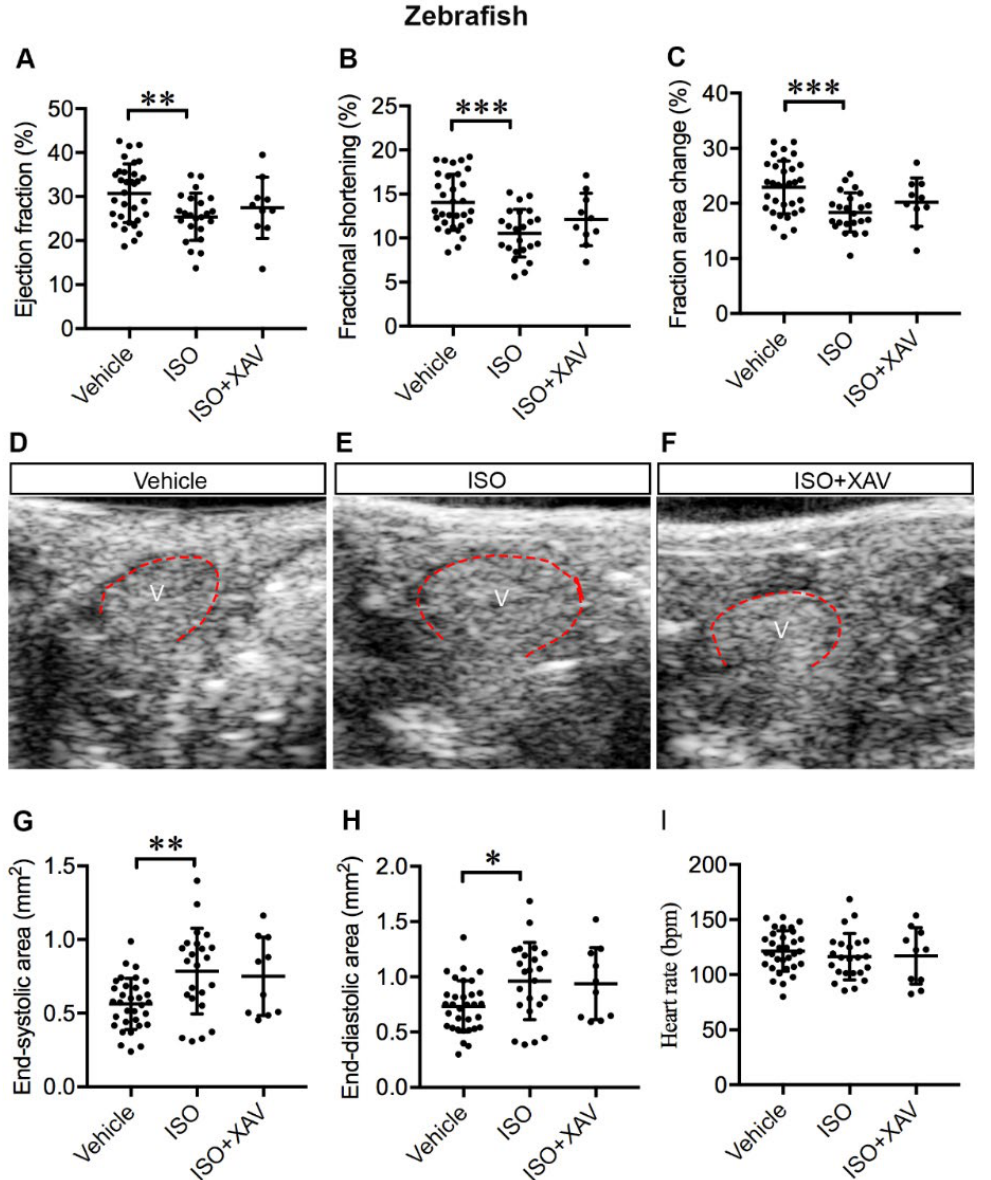
Figure 7. Tnks inhibition protects against cardiac dysfunction and ventricle dilatation induced by ISO in adult zebrafish. ( A – C ) Echocardiography depicts restored systolic function upon XAV939 treatment in ISO-treated hearts as determined by the ejection fraction ( A ), fractional shortening ( B ) and fractional area change ( C ). ( D – F ) Representative LAX images of adult zebrafish that received vehicle ( D ), ISO ( E ), or ISO and XAV939 ( F ) for 7 days. V: ventricle outlined in red, anterior to the left. ( G , H ) XAV939 treatment prevents ventricular dilatation as depicted by the preserved end-systolic ( G ) and end-diastolic ( H ) areas. ( I ) Heart rate displays no significant difference between the groups. Vehicle, n = 32; ISO, n = 23; ISO+XAV939, n = 10. Data are presented as mean ± SD. One-way ANOVA with Tukey adjustment for multiple comparisons: * p < 0.05, ** p < 0.01, *** p < 0.001.